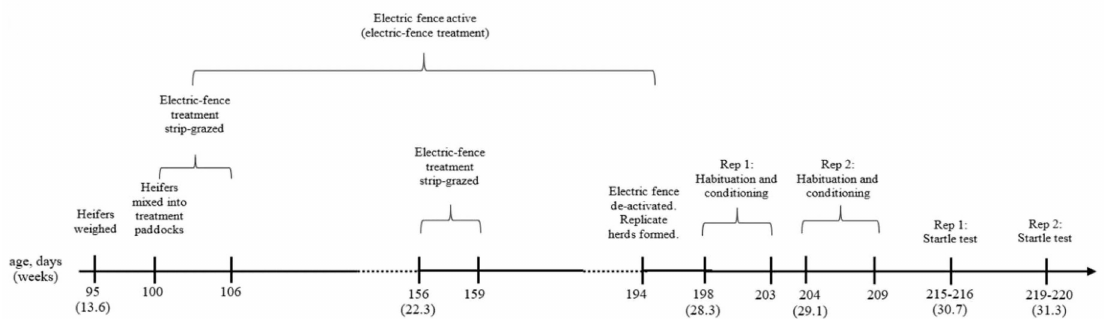
Figure 1. Experimental timeline showing the mean age of heifers in days (with mean age in weeks presented in parenthesis) at which events